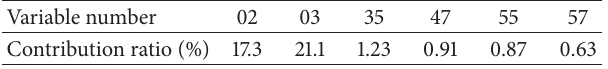
Table 4: The sensitivity of main parts weight and